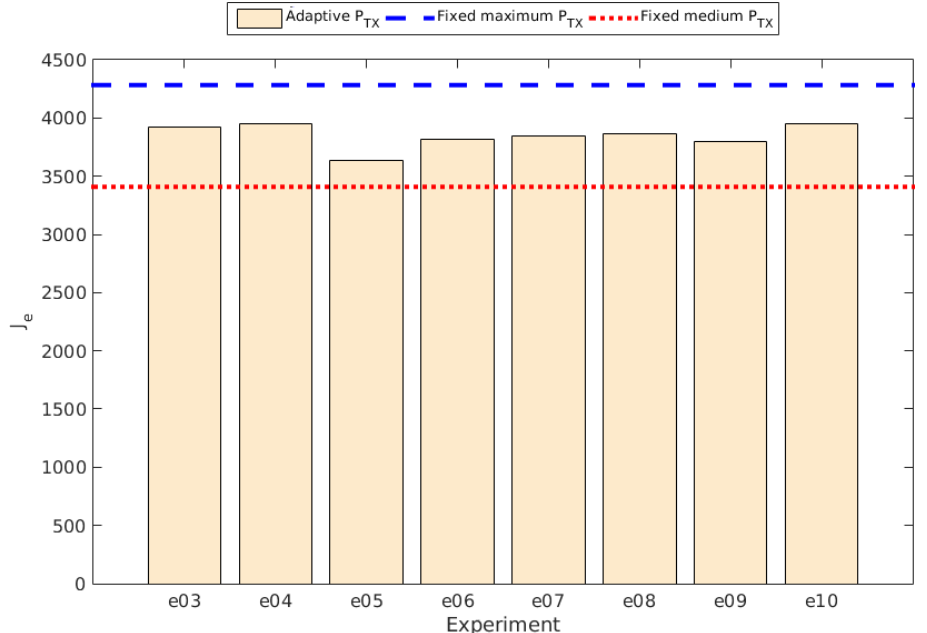
Figure 9. J comparison between e